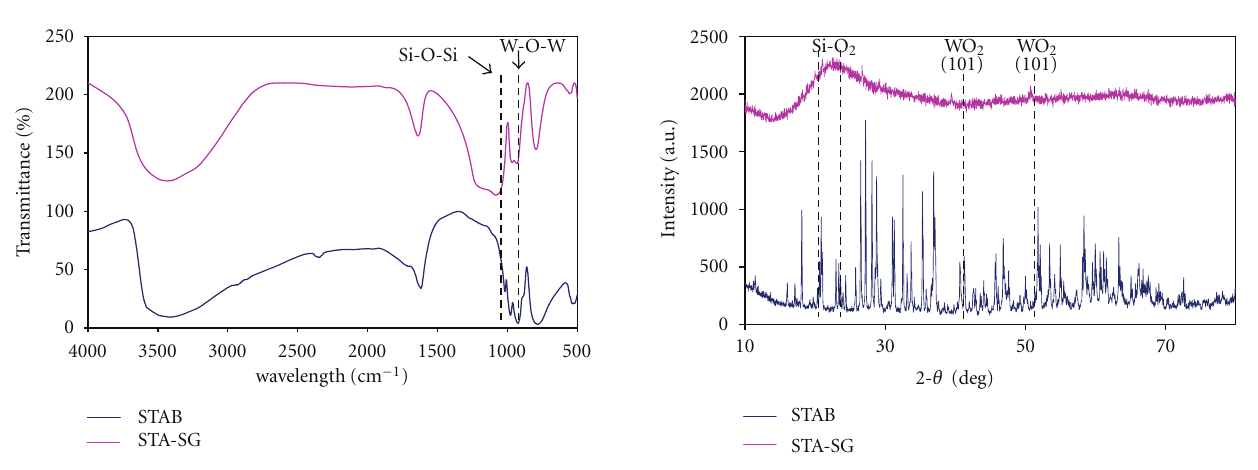
Figure 1: FTIR spectrum of STAB and STA-SG. Table 1: BET surface area for STAB and STA-SG catalyst. Type of catalyst BET surface area (m 2 /g) STAB 0.98 STA-SG 460.12